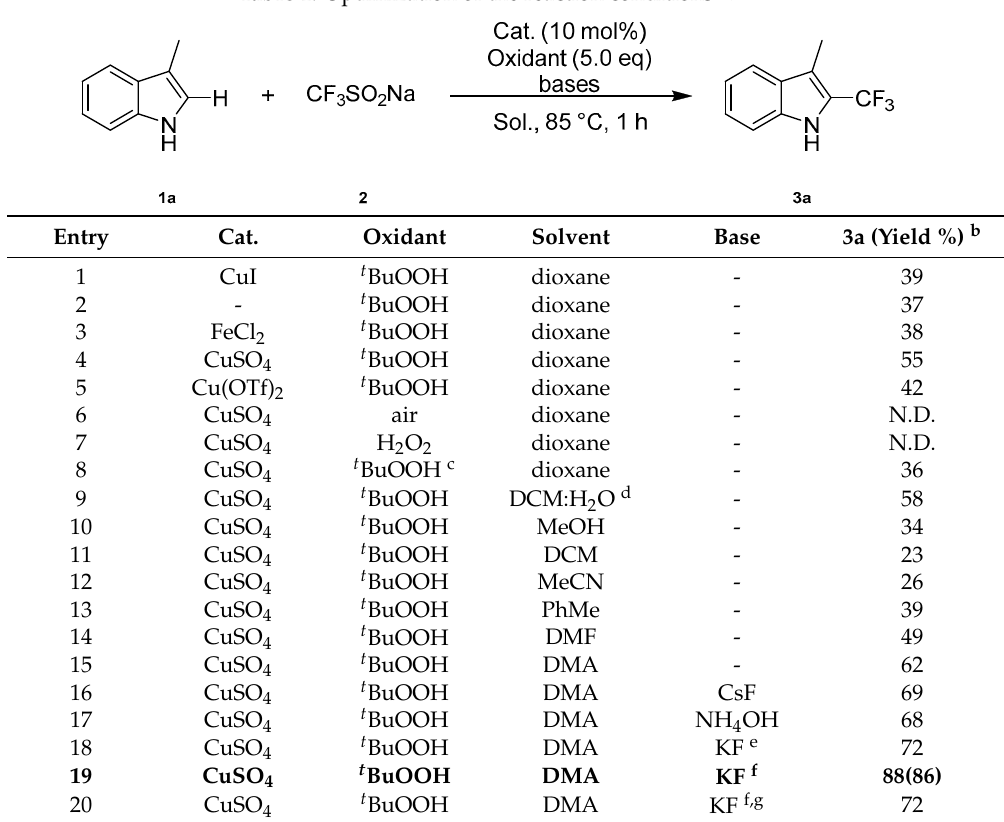
Table 1. Optimization of the reaction conditions a .